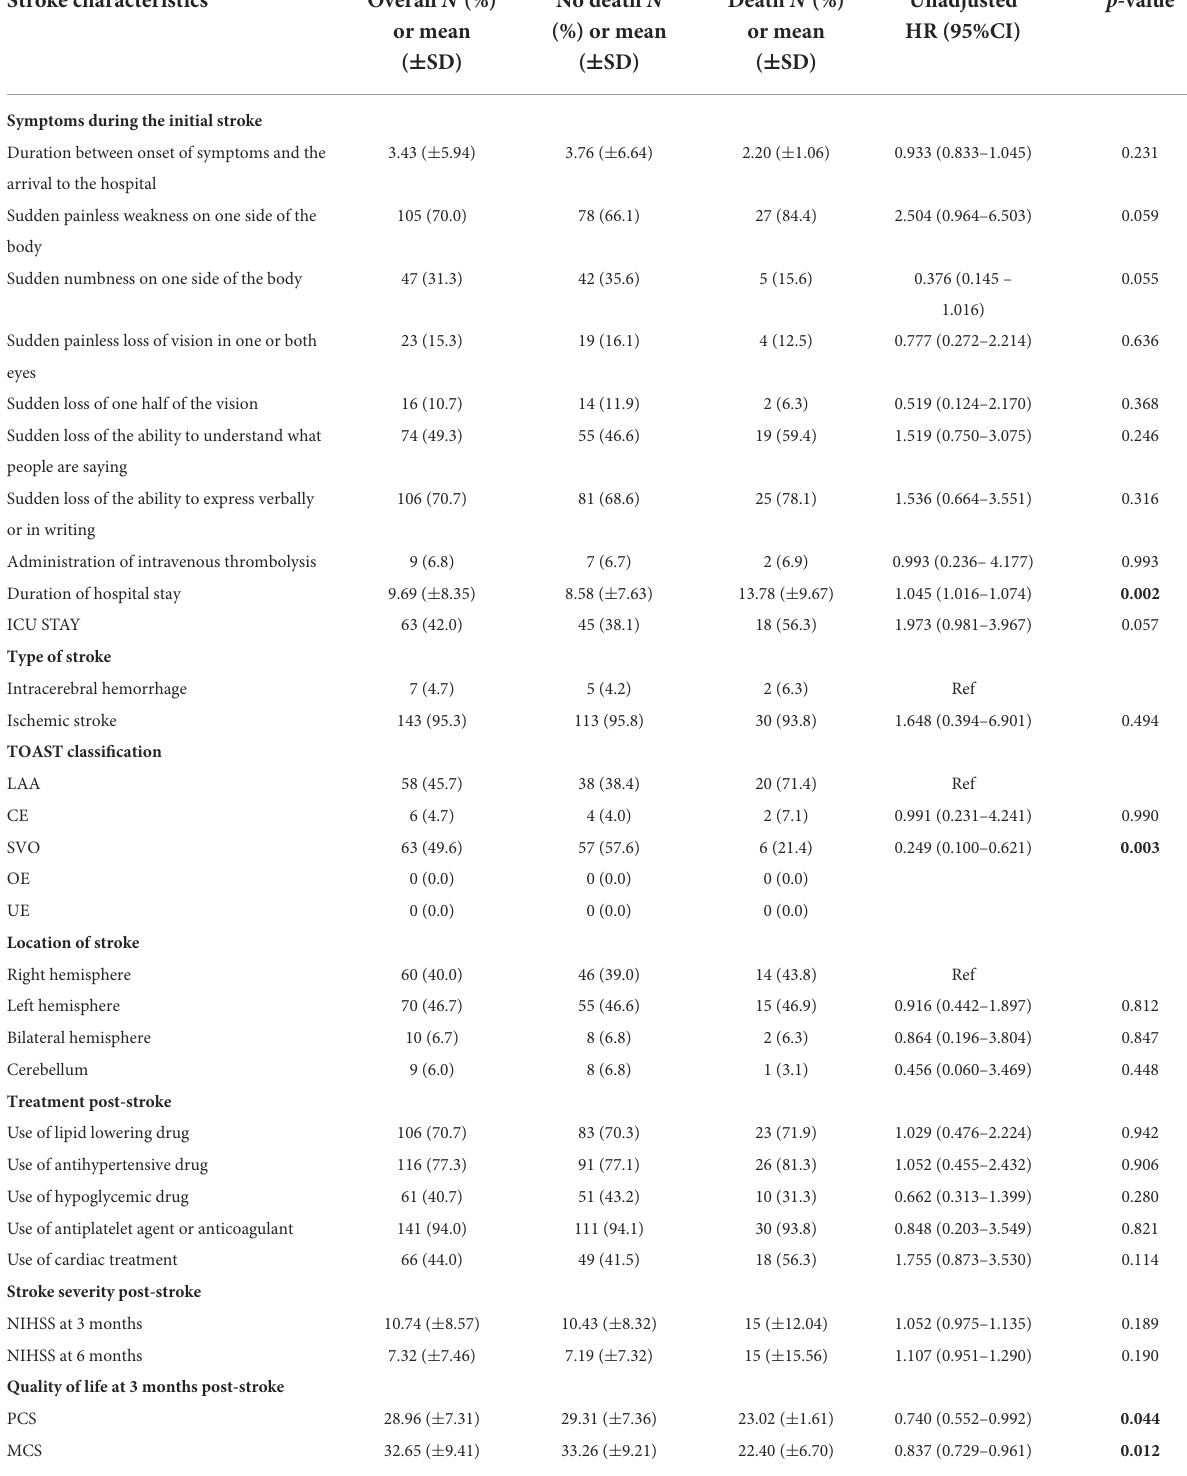
TABLE 7 The association of stroke in-hospital course and complications post-stroke with 1-year any-cause of death post-stroke using cox proportional hazard regression univariate analysis. Stroke